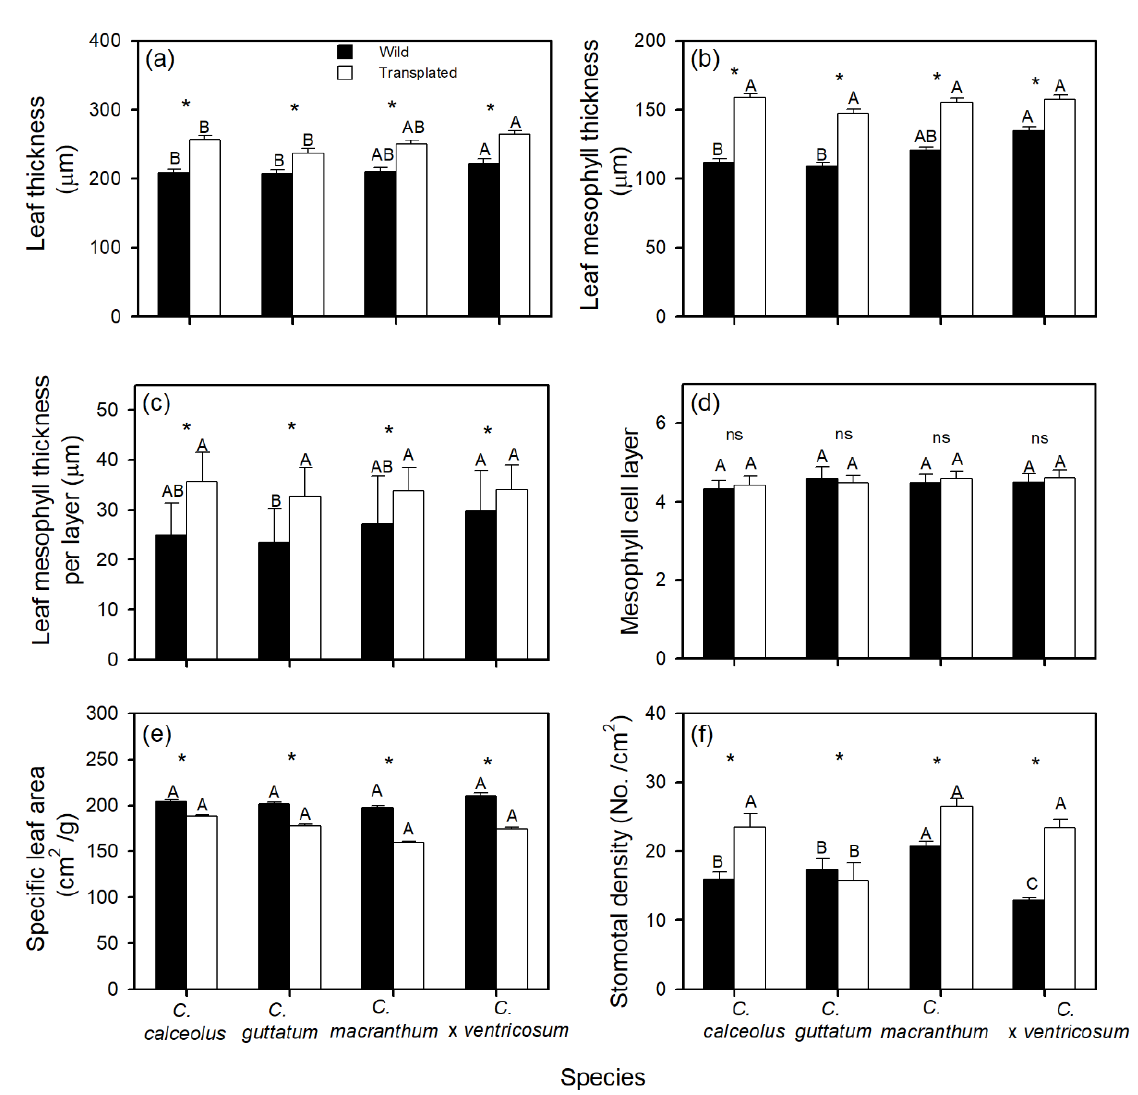
Figure 2. Leaf thickness ( a ), mesophyll thickness ( b ), mesophyll thickness per layer ( c ), and mesophyll cell layer ( d ), specific leaf area ( e ) and stomatal density ( f ) in four wild and transplanted Cypripedium species. The error bars represent 1SEM. * and ns indicate the difference between wild and nursery at the significant and insignificant levels, respectively. Different capital letters within same habitat represent a significant difference among different species according to Fisher’s LSD.